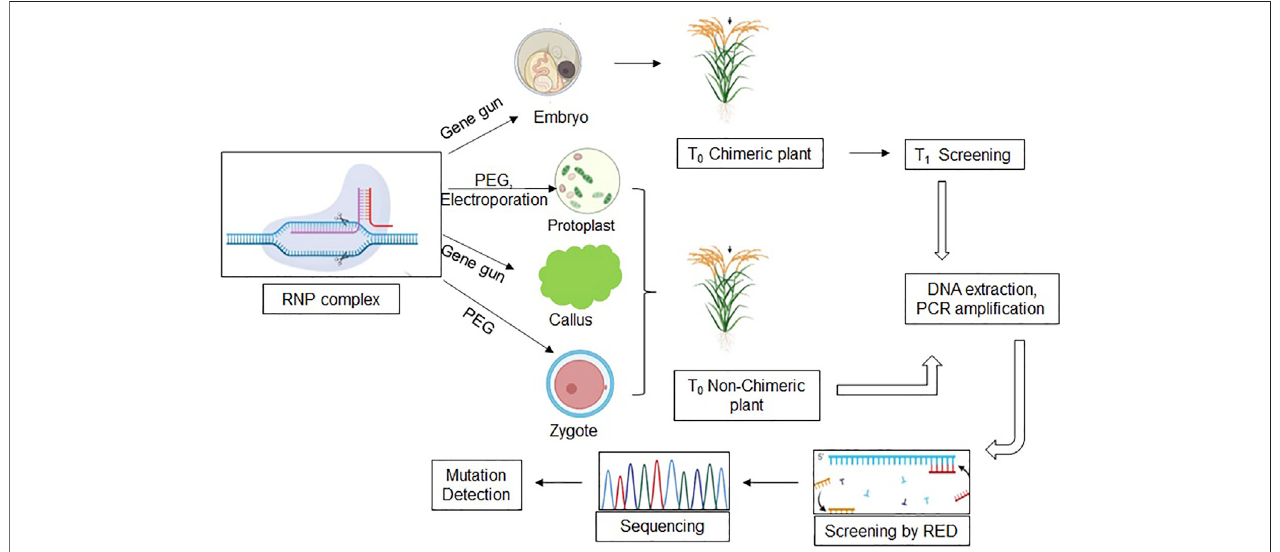
FIGURE 2 | A schematic model of the CRISPR-based RNP method. The model summarizes the use of various explants (protoplast, embryo, zygote, and callus) and the protocol used for genome editing to produce SMG-free transgenic rice. RNP, (Ribonucleoprotein) complex; PEG, (Polyethylene glycol); RED, (Restriction enzyme